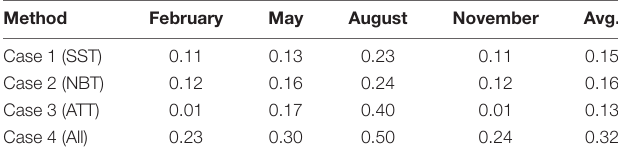
TABLE 1 | Sensitivity tests with reasonable random errors in each